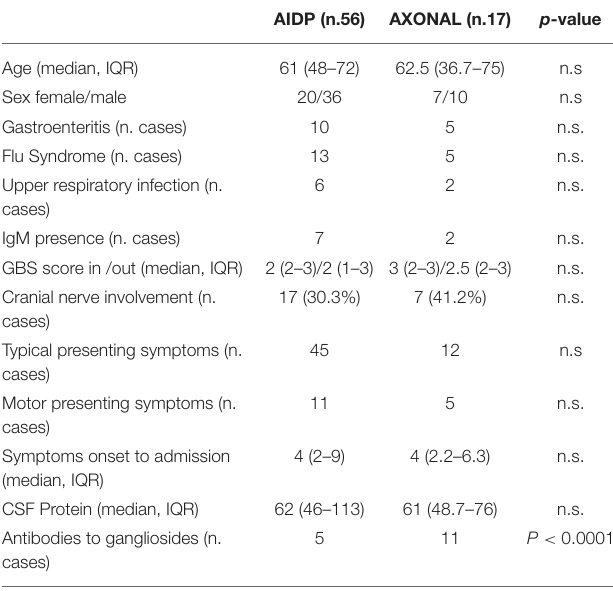
TABLE 2 | Comparison between patients with AIDP form and those with axonal (AMAN/AMSAN) form. AIDP (n.56) AXONAL